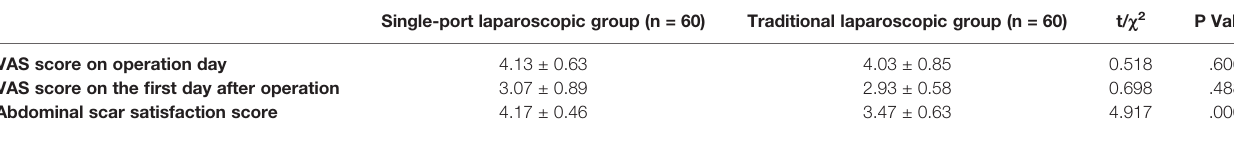
TABLE 3 | Comparison of VAS score and abdominal scar satisfaction score of each group. Single-port laparoscopic group (n =